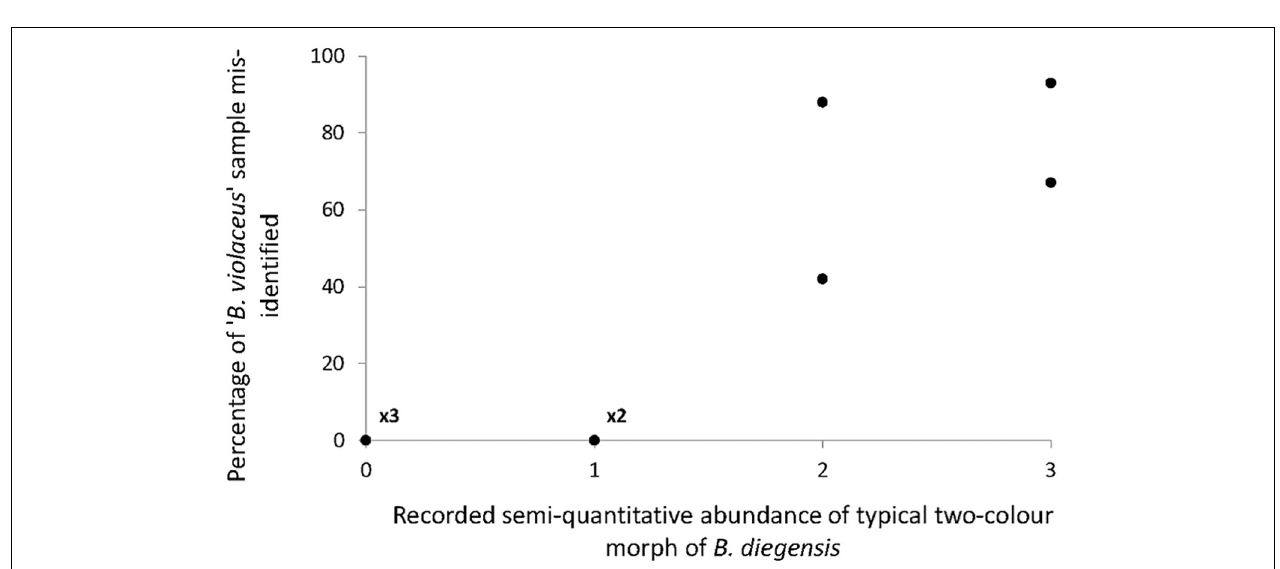
FIGURE 3 | COI phylogenetic tree based on Botrylloides sequences obtained from samples in the English Channel, reference sequences (see Figure 2 ), and sequences obtained from samples from the Mediterranean Sea (published data or from this study; see details in Supplementary Table S2 ). The tree was built with MEGA 7 by the Maximum Likelihood Method based on the Hasegawa-Kishino-Yano model with 54% of sites evolutionarily invariable. It is made of 52 sequences over 395 base pairs. They include sequences obtained from Mediterranean Botrylloides either newly collected or obtained from GenBank (see Supplementary Table S2 for codes and details). In addition, we included 6, 5, and 5 haplotypes from our reference sequences for B. diegensis , B. violaceus and B. leachii ‘radiata’ morph (open triangle symbols in green, red and blue, respectively), together with the haplotype named as BvX-H6 (violet diamond) (see details in Supplementary Tables S3 , S4 ). The tree is drawn to scale, with branch lengths measured as number of substitutions per site indicated in italics below the branch. Numbers in bold on nodes indicate percent bootstrap support values (1000 bootstraps).